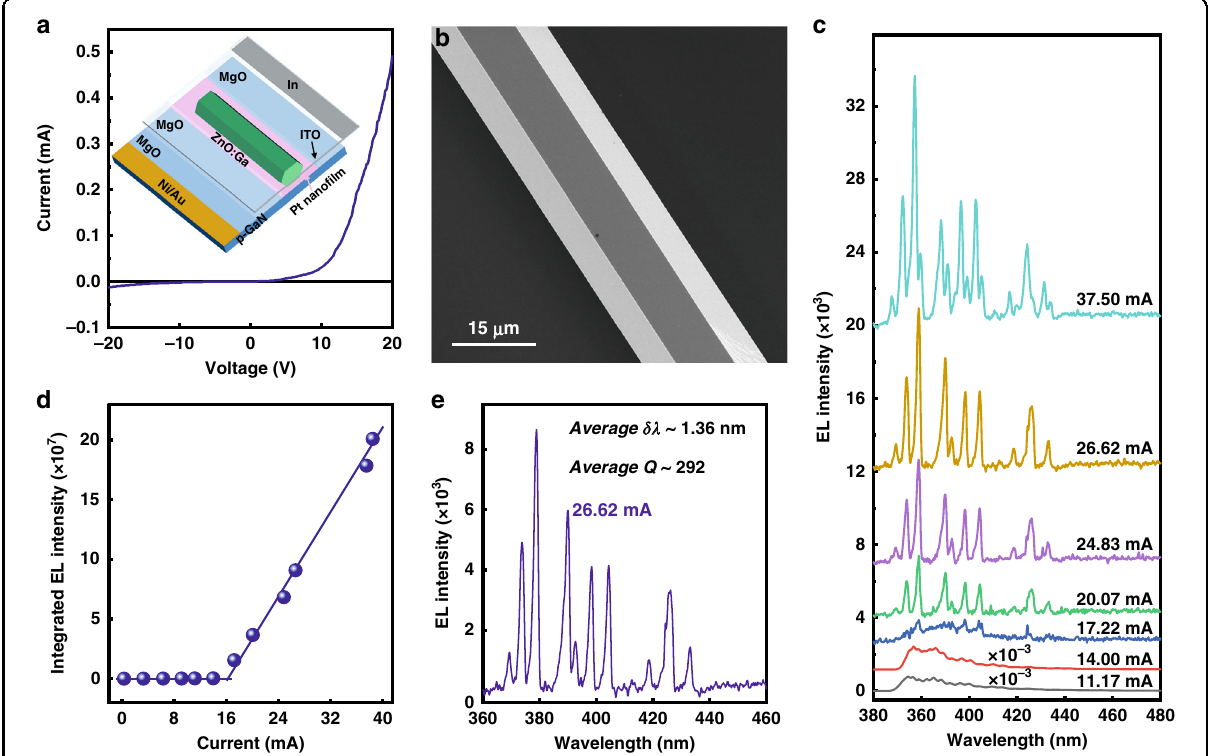
Fig. 3 Fabrication and characterization of electrically driven microlaser, showing multimode lasing actions. a I – V curve of the fabricated n- ZnO:Ga MW/Pt/MgO/p-GaN heterojunction device. Inset: A schematic illustration of the fabricated ultraviolet microlaser, which is consisting of a bare ZnO:Ga MW, Pt/MgO buffer layers and p-type GaN fi lm. b SEM observation of an individual ZnO:Ga MW, showing hexagon-shaped cross-sectional pro fi le and smooth side surfaces. c Injection current-dependent EL emission spectra of the as-fabricated single MW heterojunction emission device, with the input current varying in the range of 11.17 – 37.50 mA. d Integrated EL intensity as a function of injection current, yielding a lasing threshold of 16.4 mA. e EL spectrum via Lorentz fi tting at an operating current of 26.62 mA, providing the average linewidth of the lasing peak δλ ~ 1.36 nm, and the corresponding Q -factor is calculated to about